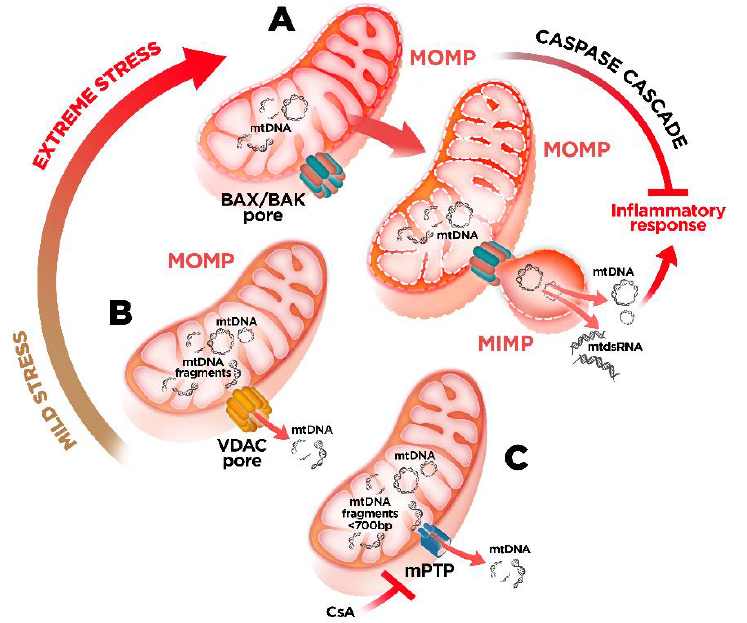
Figure 2. Proposed mechanisms of mtDNA release to the cytosol: ( A ) Under extreme stress conditions, activation of BAX/BAK leads to MOMP. Following MOMP, the outer membrane pores progressively widen, allowing for the extrusion of inner mitochondrial membrane into the cytosol and its permeabilization to release mitochondrial nucleic acids. ( B ) Under mild-stress conditions, VDAC oligomer pores promote MOMP and thus make mtDNA release into the cytosol possible. ( C ) mPTP opening allows the release of small mtDNA fragment. Abbreviations: MOMP: mitochondrial outer membrane permeabilization; MIMP: mitochondrial inner membrane permeabilization; MPTP: mitochondrial per- meability transition pore; CsA: cyclosporine A.